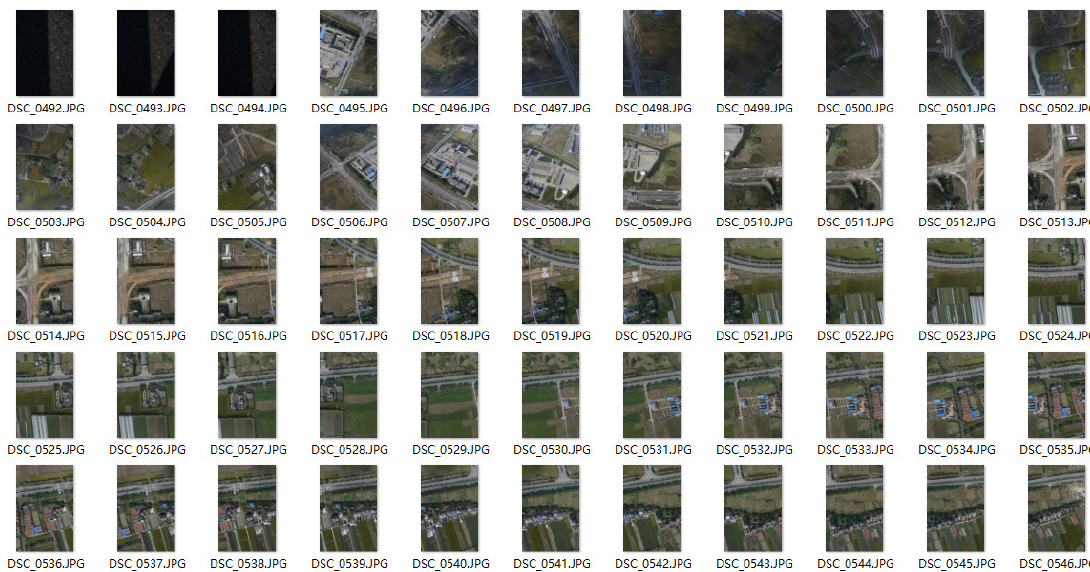
Figure 1. Unmanned Aerial Vehicle ( UAV) Remote Sensing Images.